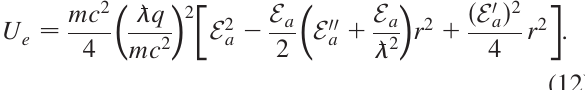
FIG. 5. (Color) Normalized deviation of ion trajectories from the initial radius at the cathode as a function of the ionization coordinate. Tracking results for r 0 ¼ 1 mm and r 0 ¼ 2 mm practically coincide with each other, confirming the linearity of ion motion close to the gun